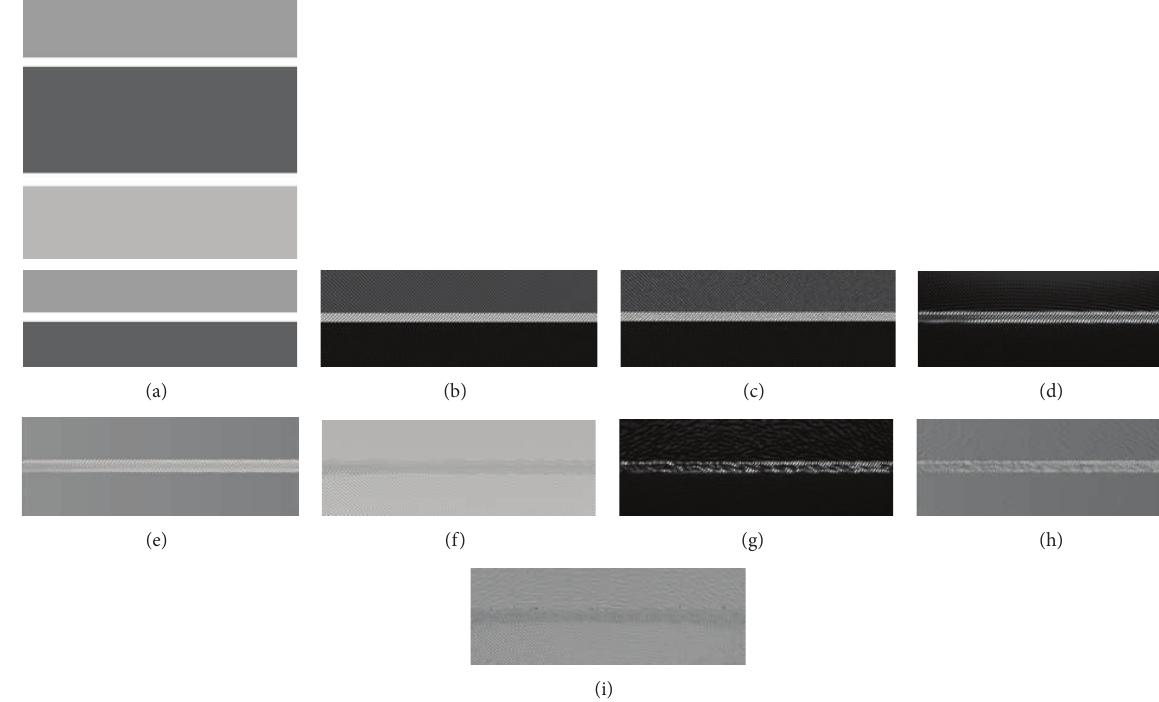
Figure 2: Results using a low frequency scale for the AM-FM methods. (a) Noise-free synthetic IA image. (b) Noise-free synthetic AM-FM image with low frequency information. (c) AM-FM image corrupted with speckle noise. (d) IA estimation from the noisy image of (c). (e) IFx estimation from the noisy image. (f) IFy estimation from the noisy image. (g) IA estimation from the denoised image using the hybrid median filter. (h) IFx estimation from the denoised image using the hybrid median filter. (i) IFy estimation from the denoised image using the hybrid median filter. Under each image we show the same AM-FM results but with a focus (zoom) on the top strip for better visual analysis